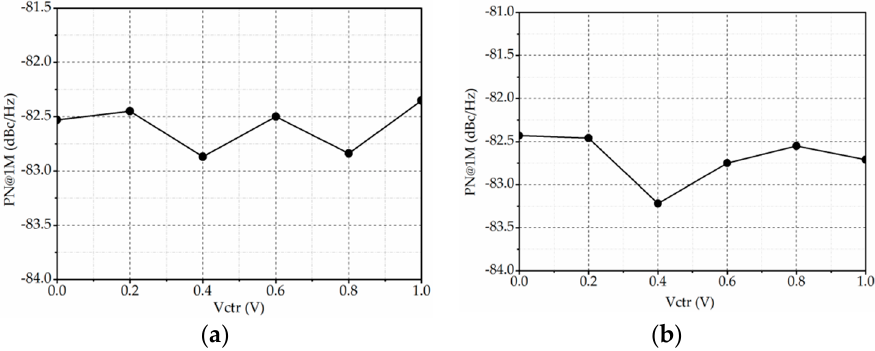
Figure 15. The simulated phase noise of the proposed VCO when the switch was on ( a ) and off ( b ).